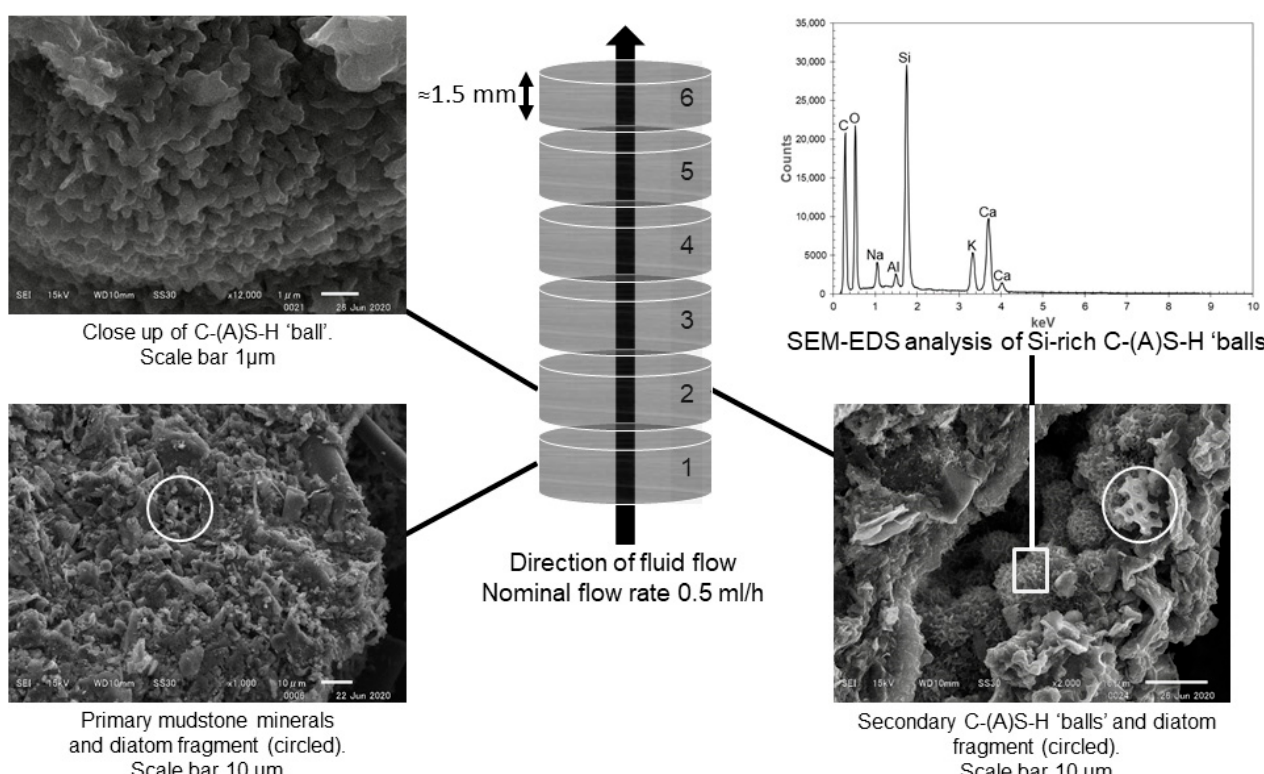
Figure 5. Summary of mineralogy of Horonobe mudstone with ‘young’ OPC leachate. All SEM photos are secondary electron (SE) images. The white square in the SEM image from Section 2 indicates the area used for SEM-EDS analysis of C(A)–S–H phases (reproduced from [14]).